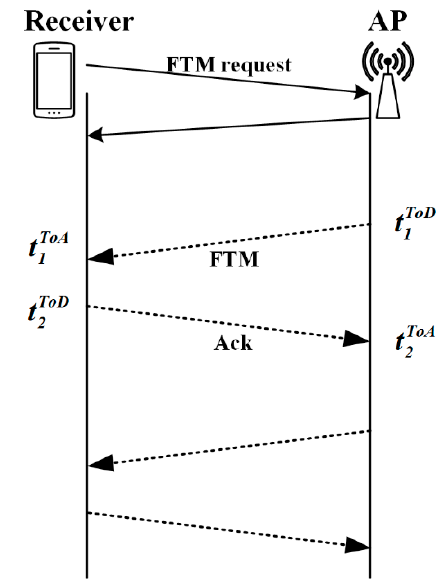
Figure 1. The fine timing measurement (FTM) protocol.